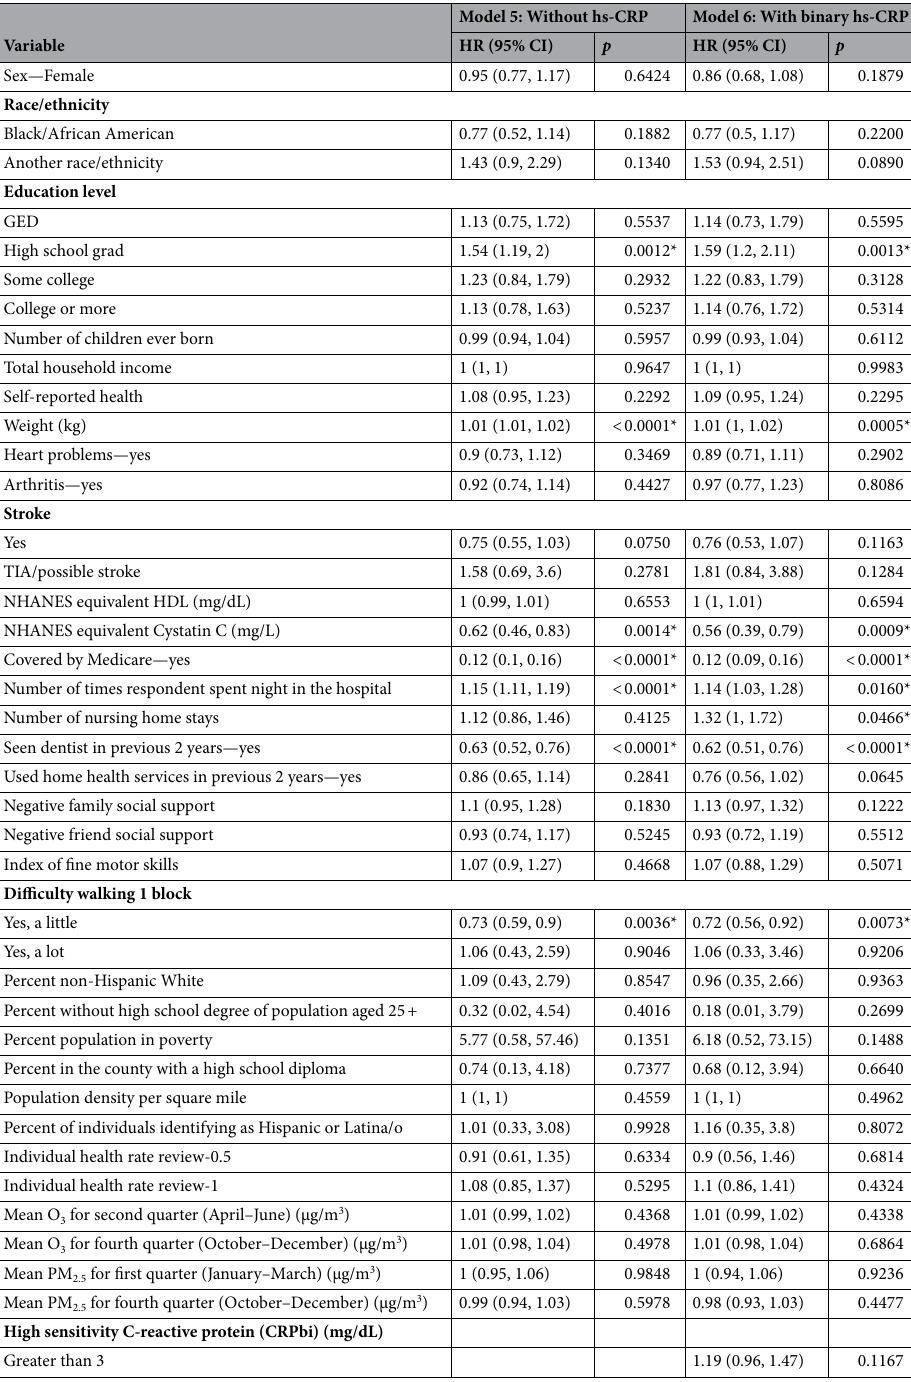
Table 4. Hazard ratios from Cox proportional hazards model of short telomere length. hs-CRP high sensitivity C-reactive protein, HR hazards ratio, CI confidence interval; N = 3084 for cox proportional hazards model without hs-CRP, N = 2,813 for cox proportional hazards model with binary hs-CRP. * p < 0.05 as significant findings in the